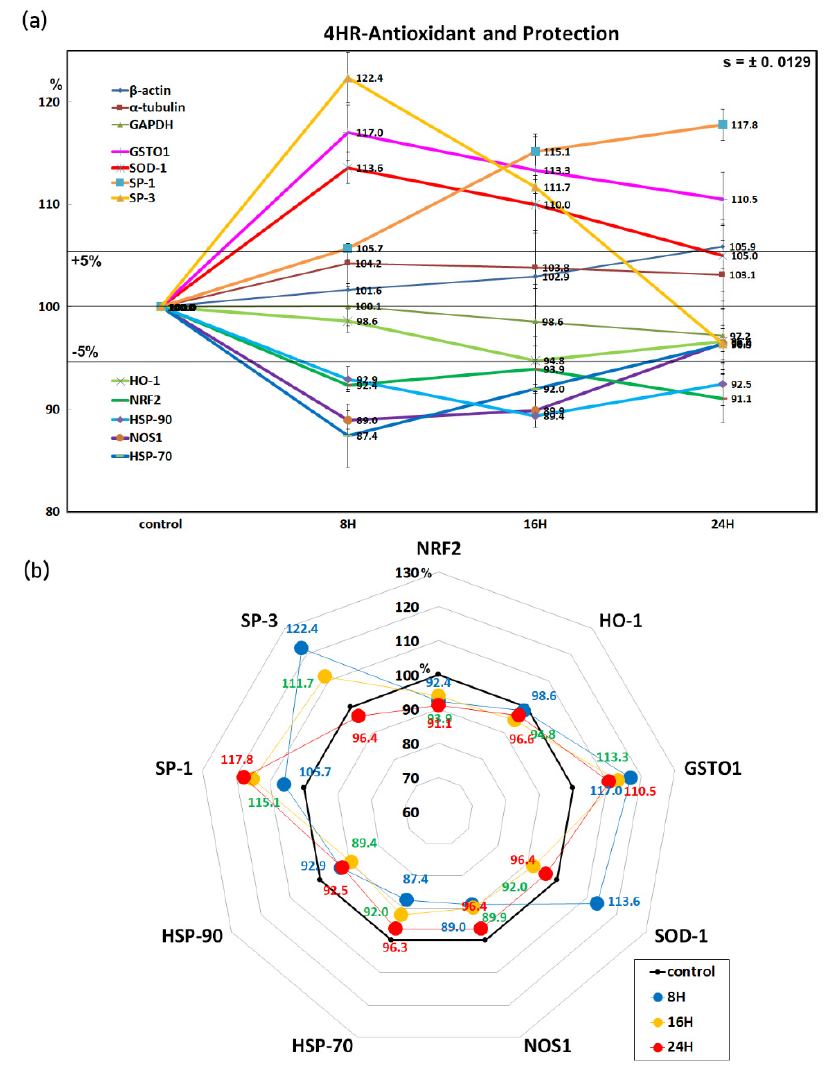
Figure 4. IP-HPLC analysis. Expression of antioxidant- and protection-related proteins in 4HR-treated HUVECs. The antioxidant proteins GSTO1 and SOD-1 were upregulated by 4HR compared to the untreated control, while the antioxidant regulating transcription factor NRF2 and the protection-related proteins HO-1, HSP-70, and HSP-90 were downregulated. On the other hand, Sp-1 expression gradually increased by 5.7%, 15.1%, and 17.8% at 8, 16, and 24 h, respectively, while Sp-3 expression increased up to 122.4% at 8 h but gradually decreased to a normal level at 24 h. The line graph ( a ) shows protein expression (%) at 8, 16, and 24 h after 4HR administration, whereas the star plot ( b ) shows the differential expression levels (%).